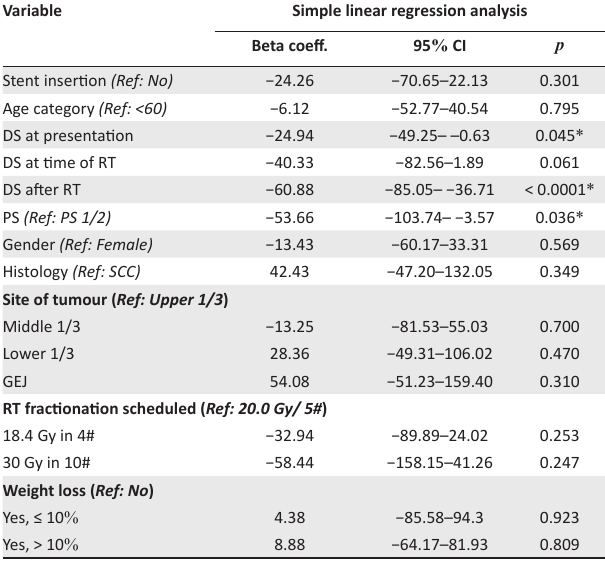
StentedNot stented